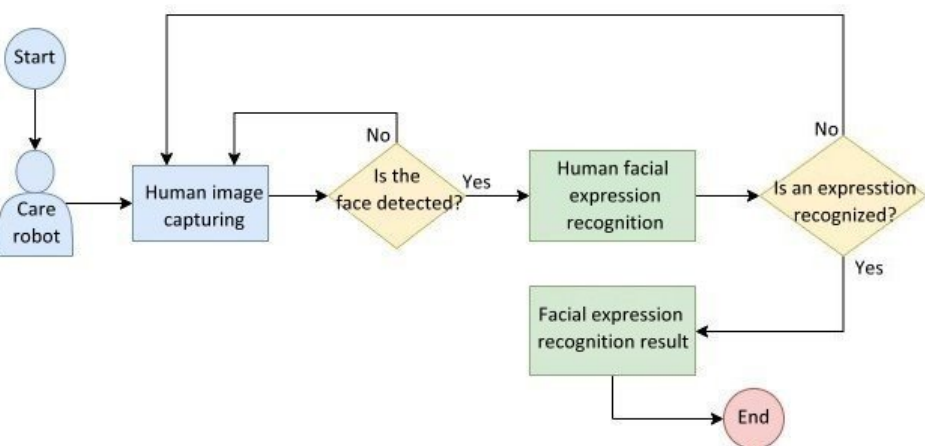
Figure 19. Behavioral flowchart of the human facial expression recognition system embedded in care robots.